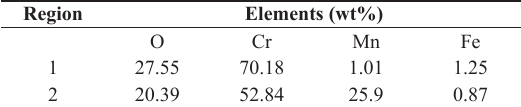
Table 1: EDS analysis results of regions 1 and 2 in